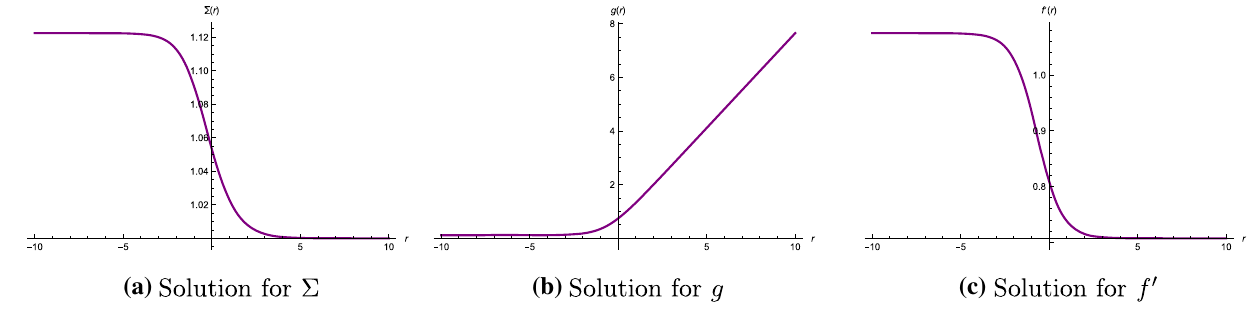
Fig. 1 An RG flow from N = 4 AdS 5 critical point with U ( 1 ) × SU ( 2 ) × SU ( 2 ) symmetry to N = 2 AdS 3 × S 2 geometry in the IR with U ( 1 ) × U ( 1 ) × SU ( 2 ) symmetry and g 1 = 1, a 5 = 1 and a 8 =